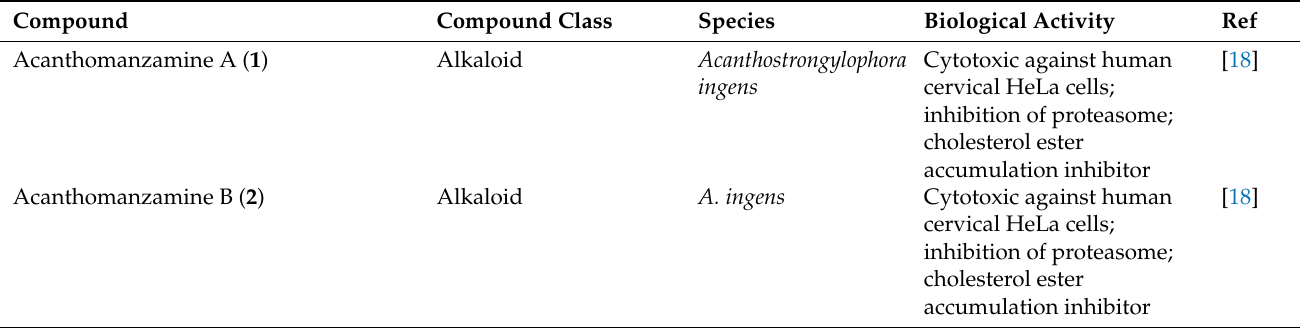
Table 1. Summary of the marine natural products isolated from the marine sponges from Indonesian oceans.